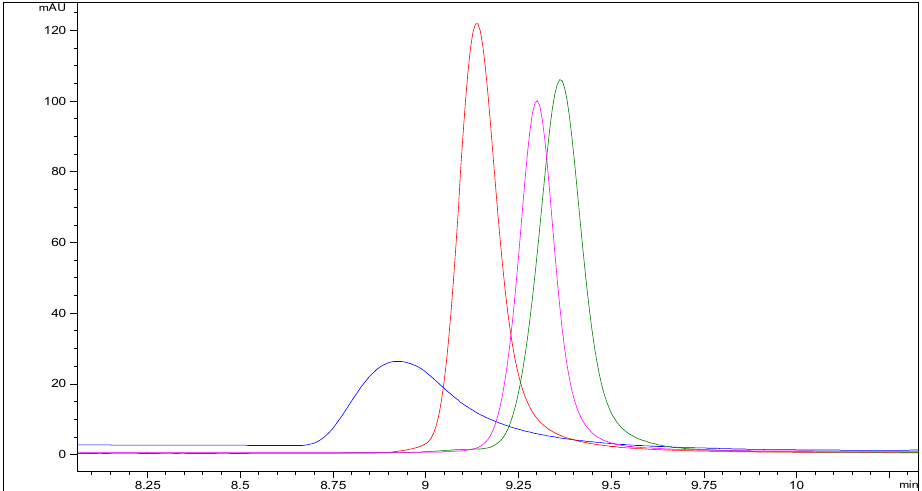
Figure A2. The effect of NaCl concentration in the mobile phase on Lf peak shape (RP column Vydac ® Protein C4 #197): 0.0 M NaCl, 0.05 M NaCl, 0.25 M NaCl, and 0.5 M NaCl. Separation was performed on Vydac ® Protein C4 #197 column at 30 °C using 0.03%TFA and NaCl in water (A) and acetonitrile (B) as a mobile phase at a flow rate of 1.0 mL/min. The gradient program is described in Section 2.2.